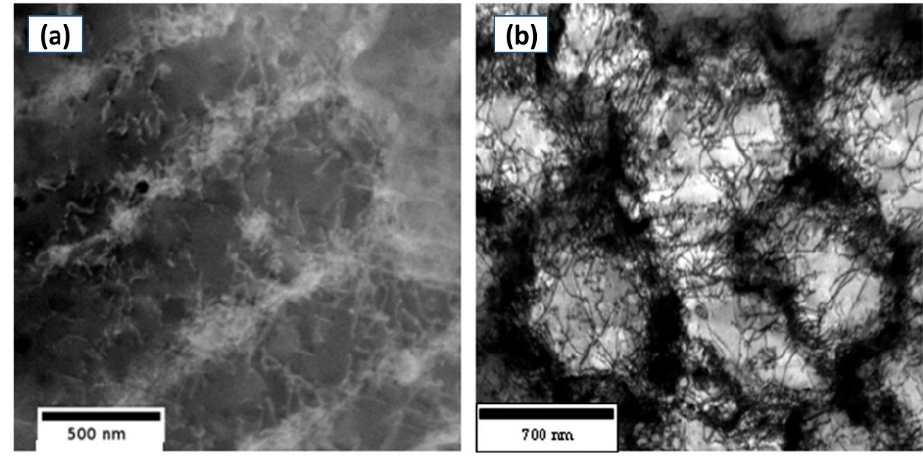
Figure 16. TEM image illustrating the dislocation network of the as ‐ printed IN718 in: ( a ) columnar microstructure; ( b ) cellular microstructure [7]. Copyright 2017, Elsevier E. V.